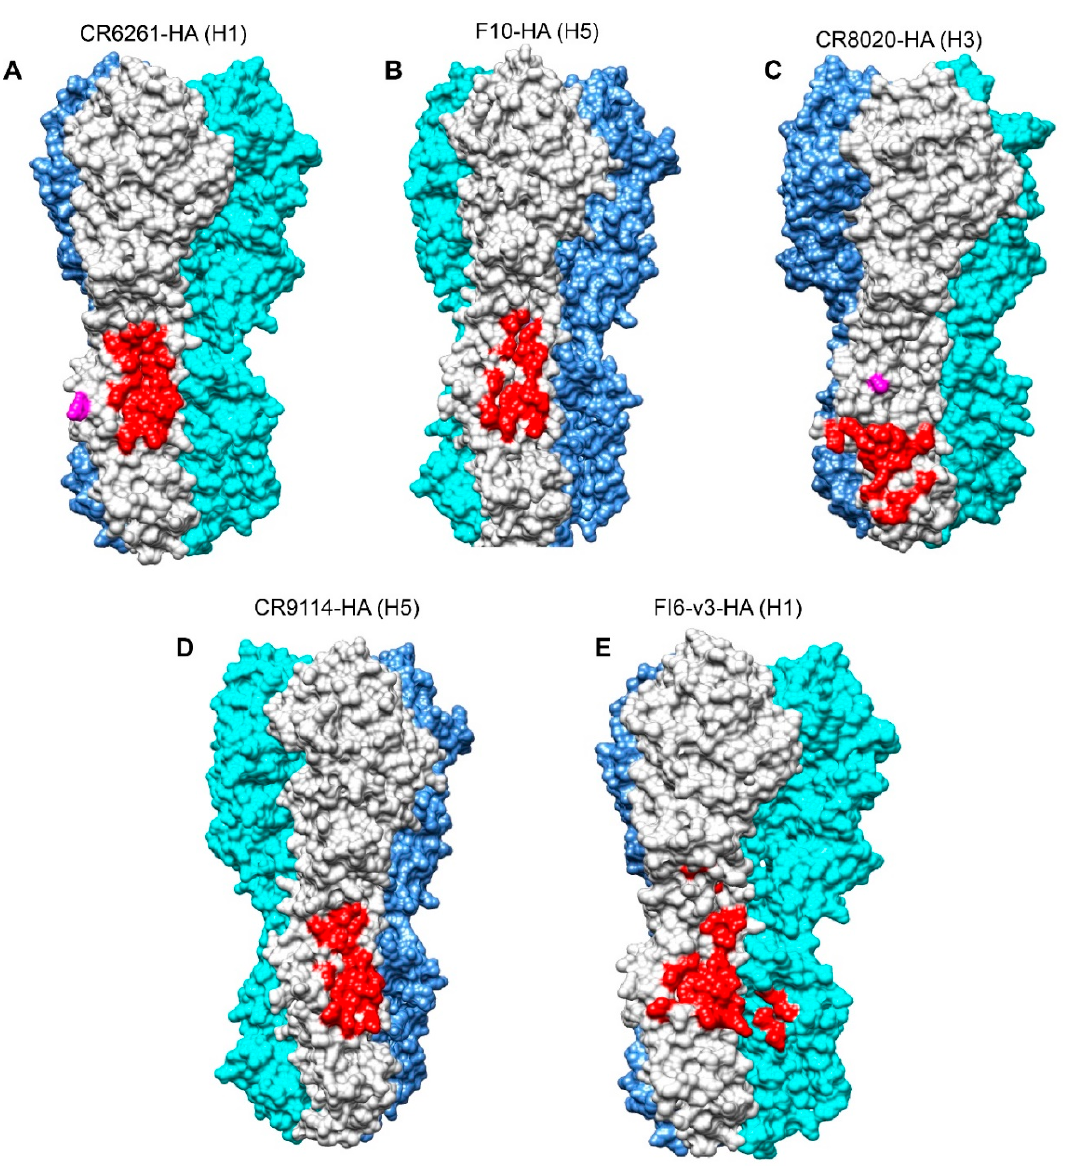
Figure 2. HA stem antibody epitope foot prints (in red). Each HA monomer is distinctly colored in light grey, cyan and cornflower blue ( A ) CR6261 epitope foot print on H1 HA (PDB code: 3LZG) [48]. ( B ) F10 epitope foot print on H5 HA (PDB code: 2FKO) [49]. ( C ) CR8020 epitope foot print on H3 HA (PDB code: 3ZTJ) [28]. ( D ) CR9114 epitope foot print on H5 HA (PDB code: 2FKO) [49]. ( E ) FI6v3 epitope foot print on H1 HA (PDB code; 3LZG) [48]. Note: Glycan (N21) that occludes the binding of CR8020 to group 1 HA in (A) or glycan (N38) reoriented for binding both group 1 and 2 HAs by CR9114 and FI6v3 in (B) is highlighted in magenta.